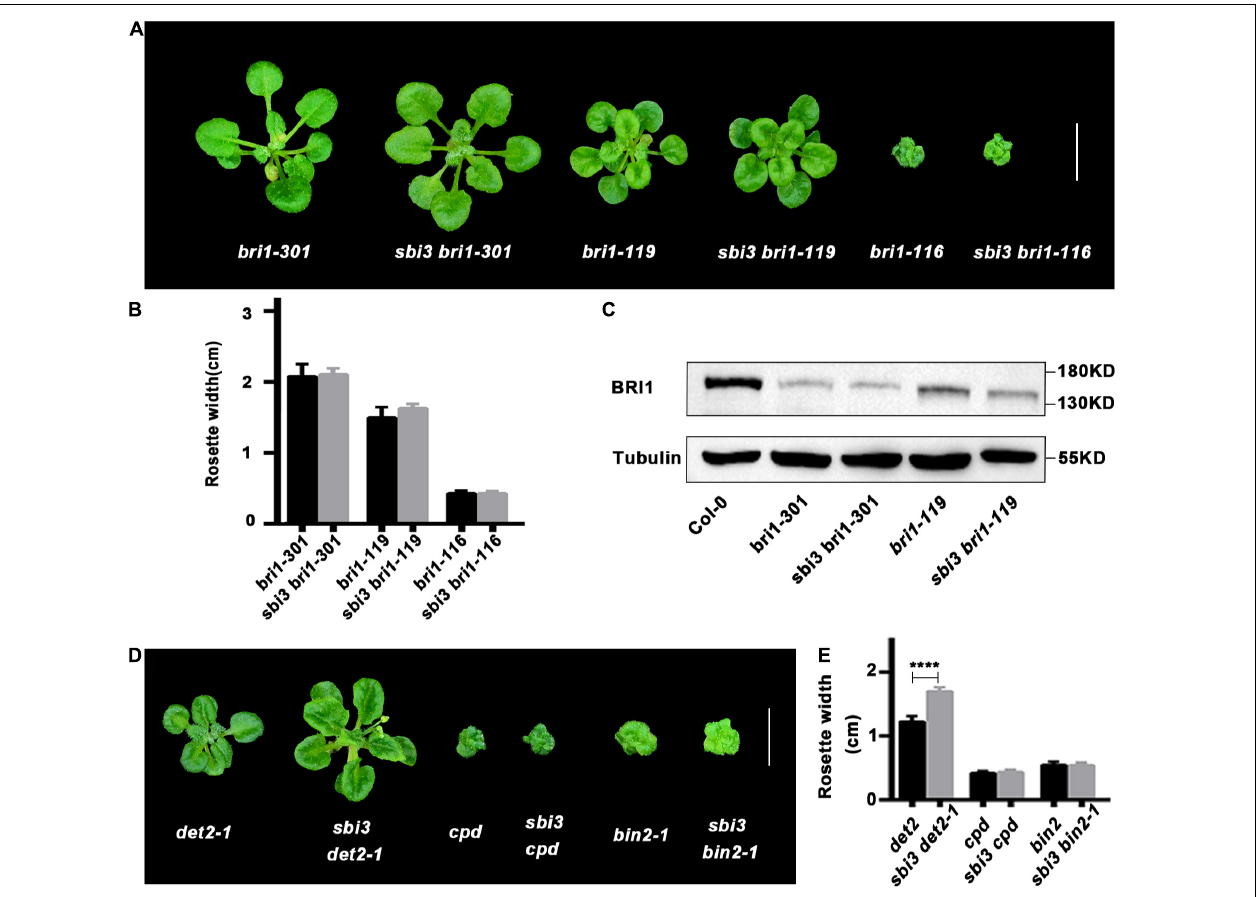
FIGURE 5 | The double mutants of other backgrounds. (A) Phenotypes of bri1-301 , bri1-119 , bri1-116 and their corresponding double mutants with sbi3 grown in soil for 3 weeks. Scale bar, 1 cm. (B) Comparison of rosette width of 3-week-old plants measured using the ImageJ software. Error bar represents ± standard deviation (SD), n ≥ 10. *** P < 0.001 as two-way ANOVA with Tukey’s multiple comparisons test. (C) Western blotting analysis of BRI1 protein abundance in Col-0, bri1-301 , sbi3 bri1-301 , bri1-119, and sbi3 bri1-119 . (D) Phenotypic comparison of det2-1, cpd , bin2-1 and their corresponding double mutants with sbi3 grown in soil for 3 weeks. Scale bar, 1 cm. (E) The width of rosette leaves of 3-week-old plants were measured using the ImageJ software. Error bar represents ± standard deviation (SD), n ≥ 10. **** P < 0.0001 as one-way ANOVA with Tukey’s multiple comparisons